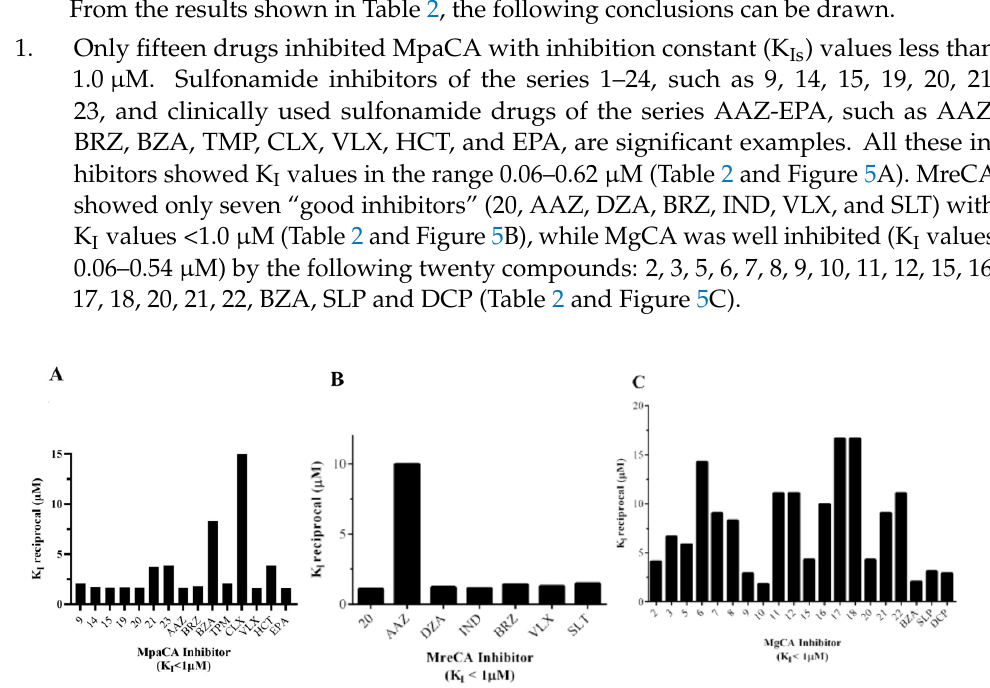
Figure 5. Graphical representation of the sulfonamide compounds exhibiting inhibitor activity with K I values < 1.0 μ M with respect to MpaCA (Panel A ), MreCA (Panel B ) and MgCA (Panel C ). The K I values are reported as the reciprocal to have the highest column to the best enzyme inhibitor.